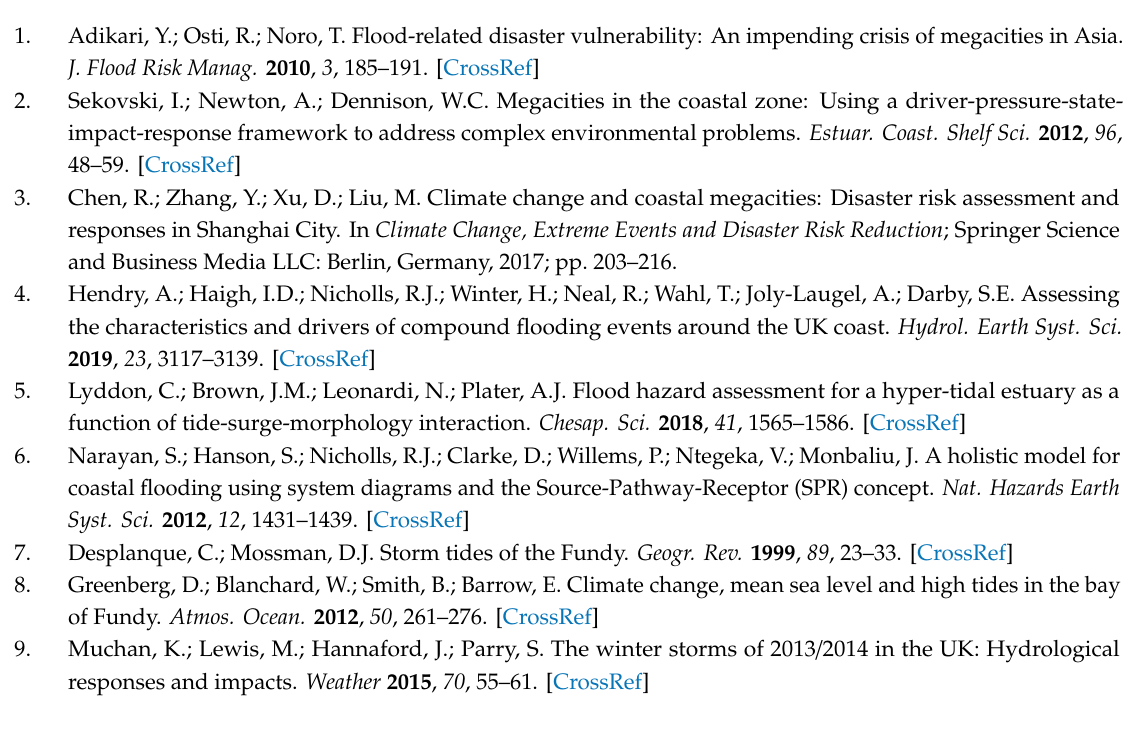
Figure S1: Depth and extent of flooding at Oldbury-on-Severn for HP approach to forcing the model boundary where maps 1-8 represent coastal hazard uncertainty (see Table 1) for December 12, Figure S2: Depth and extent of flooding at Oldbury-on-Severn for WR approach to forcing the model boundary where maps 1-8 represent coastal hazard uncertainty (see Table 1) for December 12, Table S1: Water depth percentiles for January 14 WR, Table S2: Water depth percentiles for January 14 HP, Table S3: Water depth percentiles for December 12 WR, Table S4: Water depth percentiles for December 12